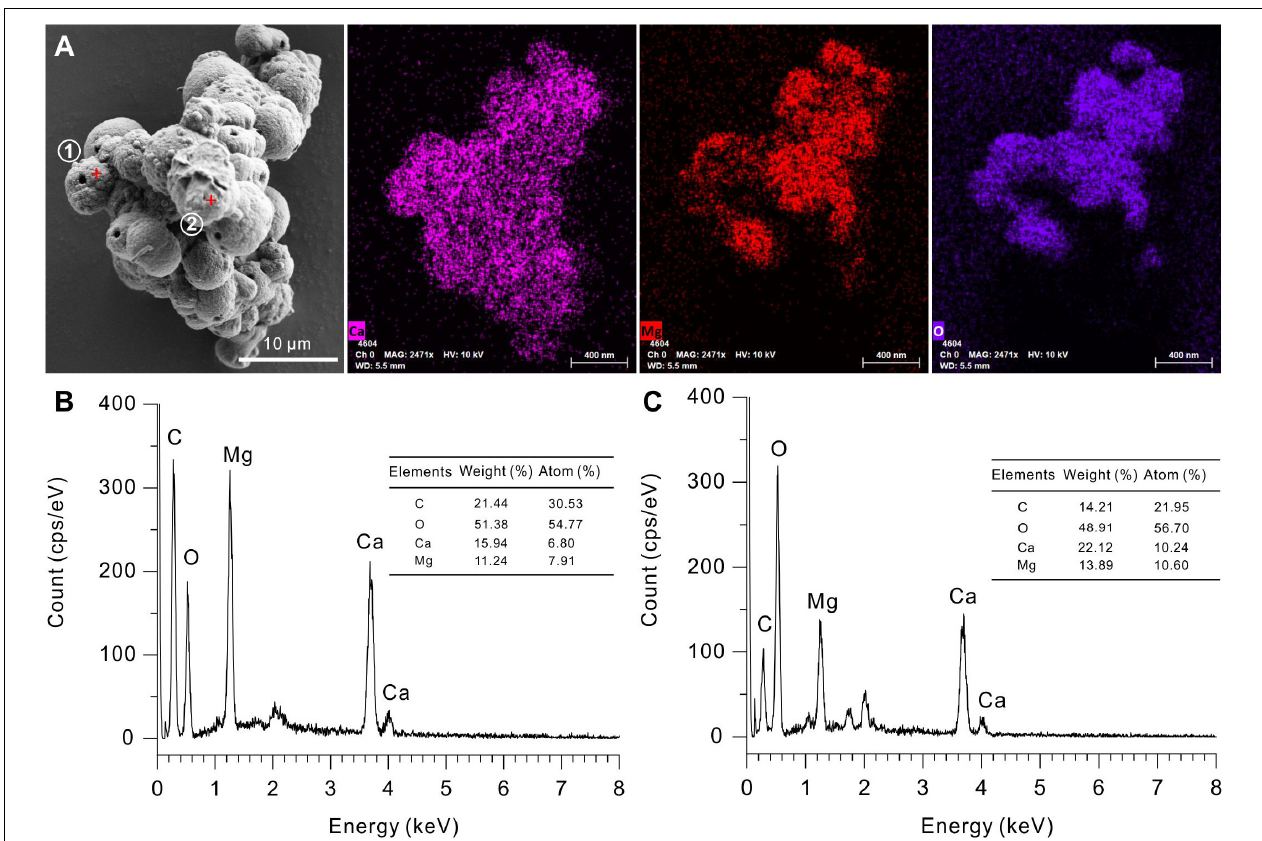
FIGURE 8 | Elemental composition of protodolomite induced by Vibrio harveyi QPL2 in LB media with different Mg/Ca molar ratios. (A) Elemental mapping of protodolomite aggregates. (B,C) Spot EDS analyses of two selected positions in panel (A) .